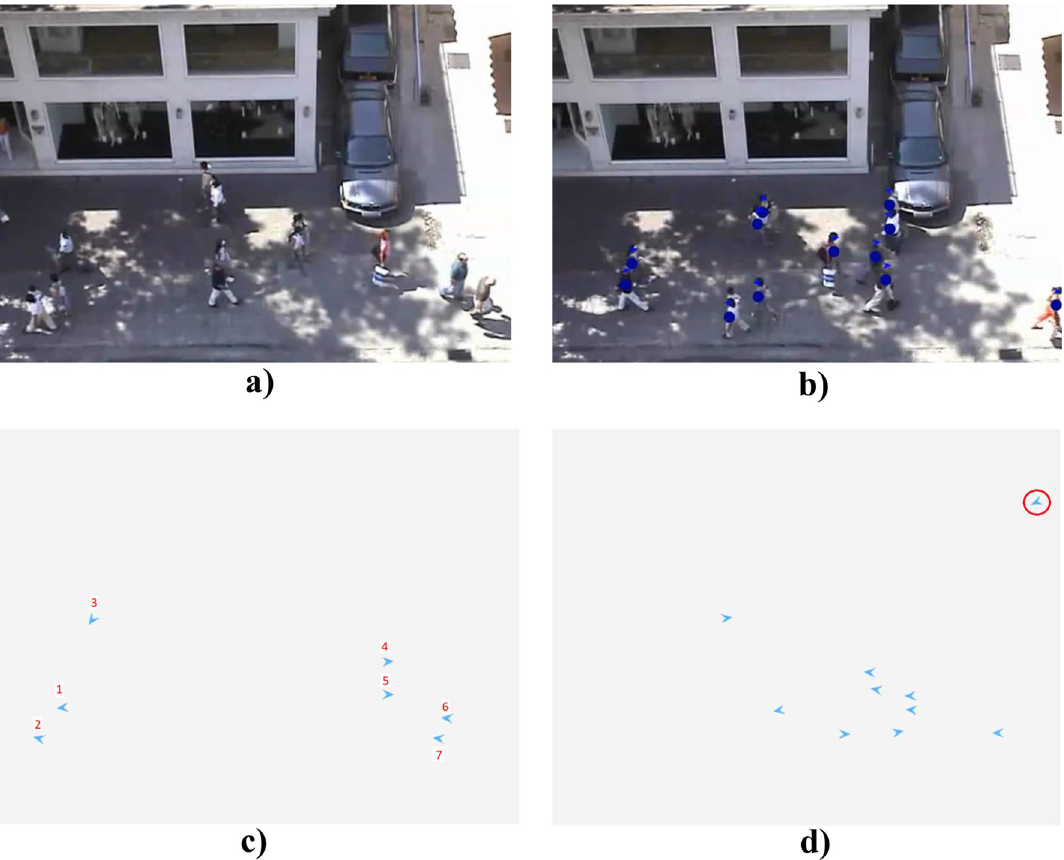
Figure 3. Overview of the survey questionnaire interface. ( a ) Training part with open-source surveillance video 38 ; ( b ) Training part, intermediate scenario; ( c ) Second part of the survey questionnaire, i.e. recognition of the motion of a ”weird” arrow in the videos, if any; ( d ) Third part of the survey questionnaire, i.e. focusing on the circled over a gray background—(Fig. 3c illustrates a frame of a single experiment); (iii) in the third and final part, the participants watched the same 21 videos (but in a different random order), where they were asked in addition to focus on a circled arrow (Fig. 3d illustrates an example of a frame of a single experiment). The participants were unaware that the circled arrow targeted a random human agent in the HO experimental condition and the robotic agent in GT and VFH experimental conditions. We remark that the seven experiments used for the survey ques- tionnaire are identical to those used to evaluate the performance parameters computed in the previous section. The execution of each part entails answering specific questions. In the first part of the survey questionnaire, the participants were required to provide their gender, age, and level of experience in robotics field on a Likert scale 40 from 1 (no experience) to 5 (expert).